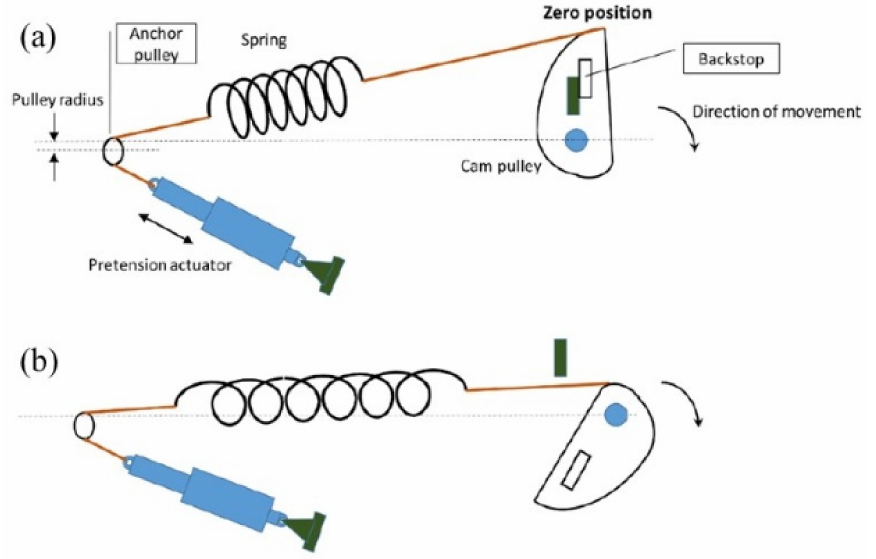
Figure 12. Mechanical linkage within the test rig to ensure constant torque from a mechanical spring at ( a ) zero and ( b ) maximum